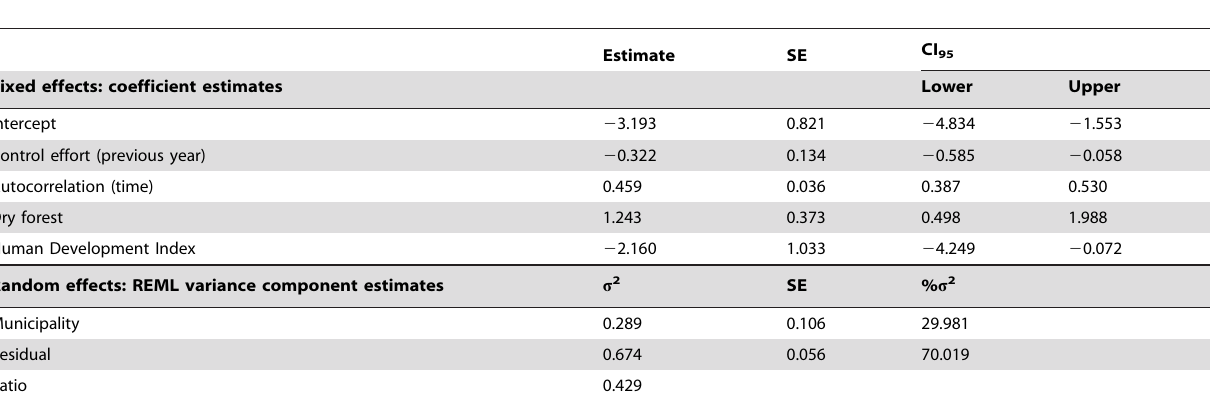
Table 3. Dwelling infestation by triatomine bugs in 39 municipalities, Cochabamba, Bolivia, 2000–2011*: linear mixed model results, with intervention effort modeled as the amount of insecticide used per census inhabitant in the previous year (number of parameters k =7; BIC= 881.63; AICc=